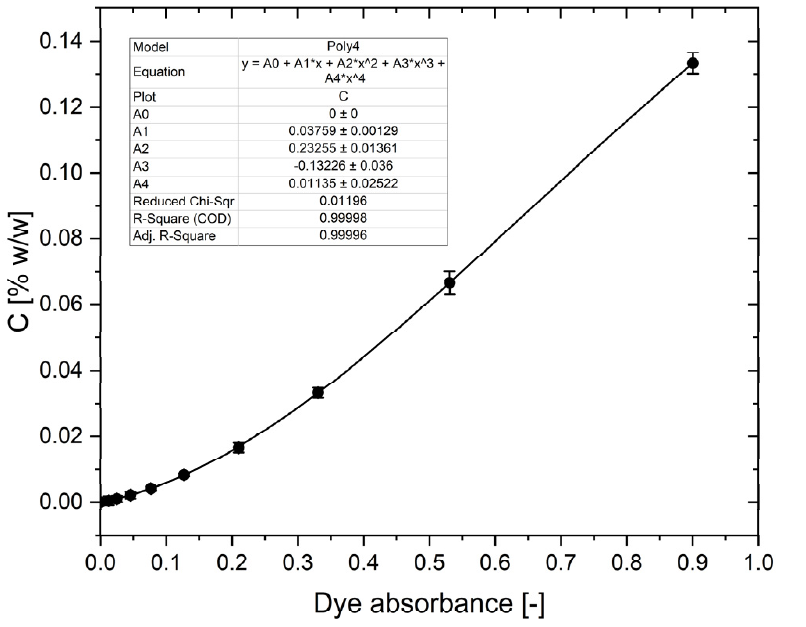
Figure 8. Calibration curve of MB in 0.2% CTAB water solution measured in microdevice’s CC at 25 °C. MB absorbance without background.